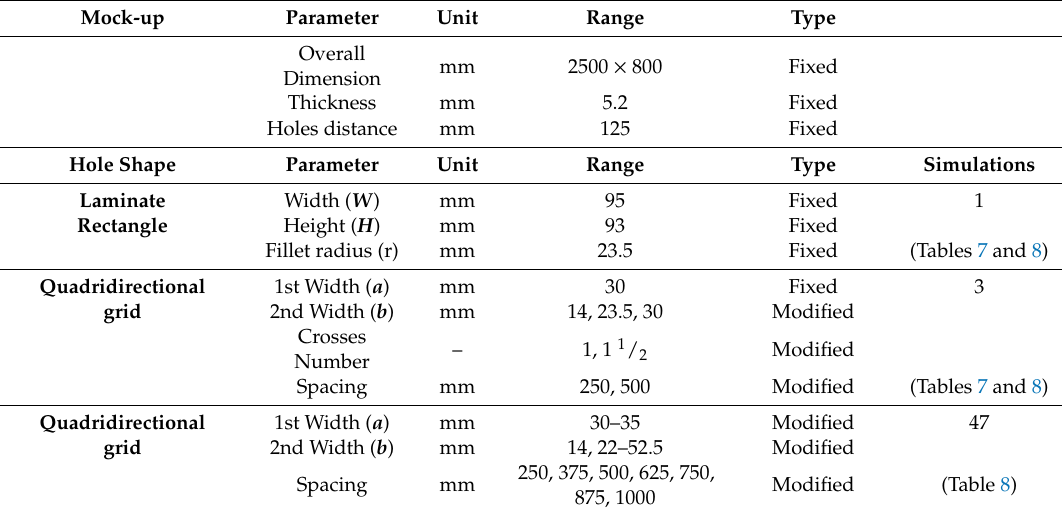
Table A2. Grid optimization on the